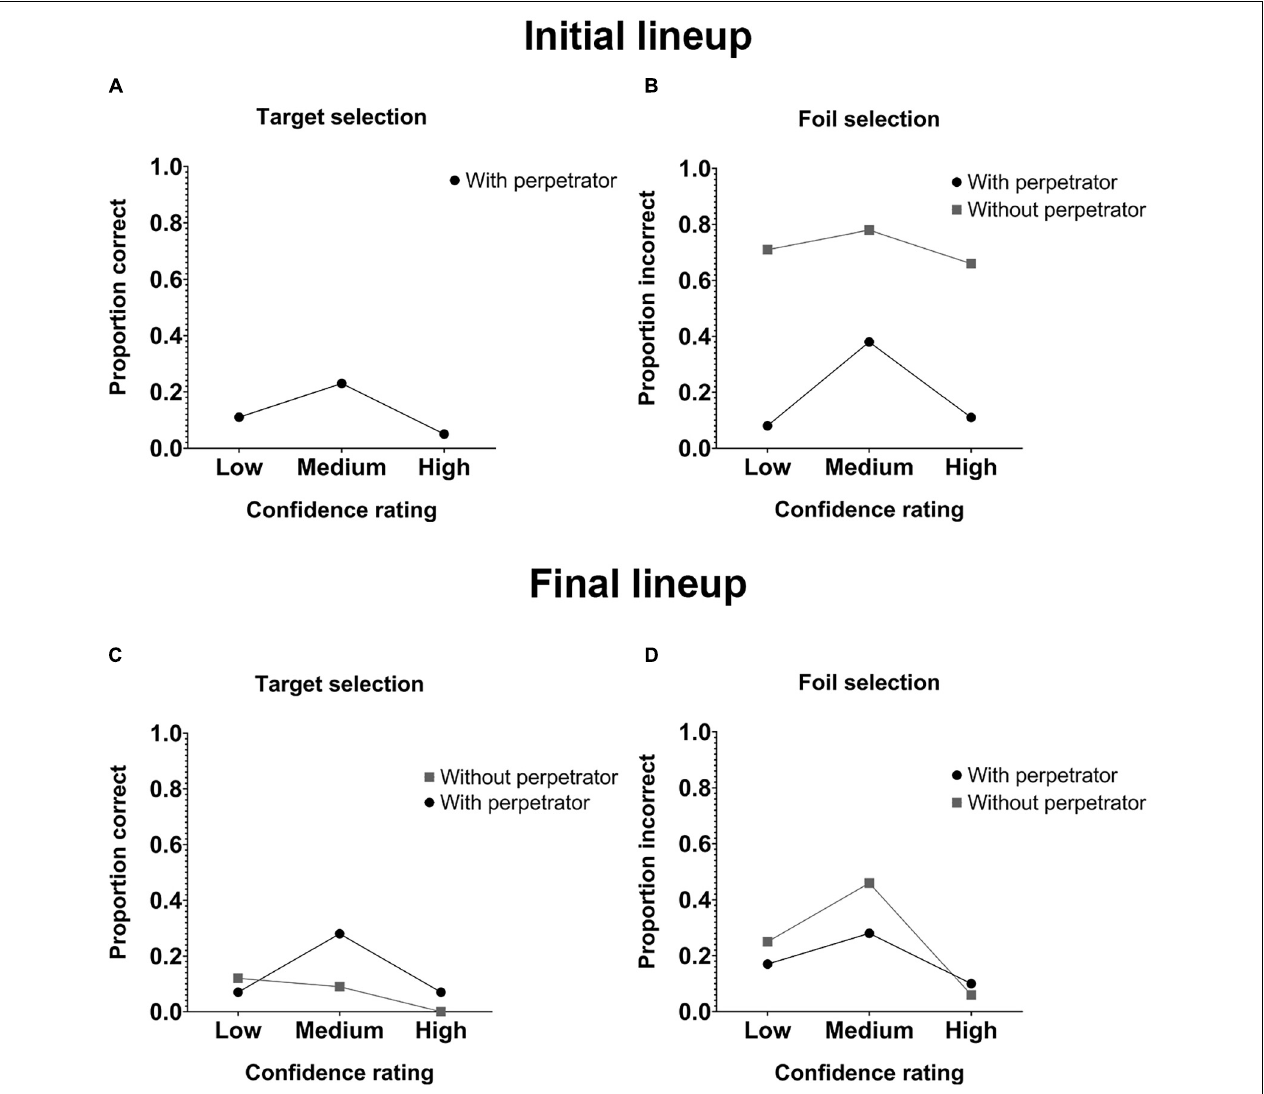
FIGURE 3 | CAC curves for participants who made an election (choosers) in the Initial and Final lineups. (A) CAC curves for the target selection of the With perpetrator group of the Initial lineup. (B) CAC curves for the foil selection of the With perpetrator and Without perpetrator groups of the Initial lineup. (C) CAC curves for the target selection of the With perpetrator and Without perpetrator groups of the Final lineup. (D) CAC curves for the foil selection of the With perpetrator and Without perpetrator groups of the Final lineup. The perpetrator was included in the Final Lineup of both